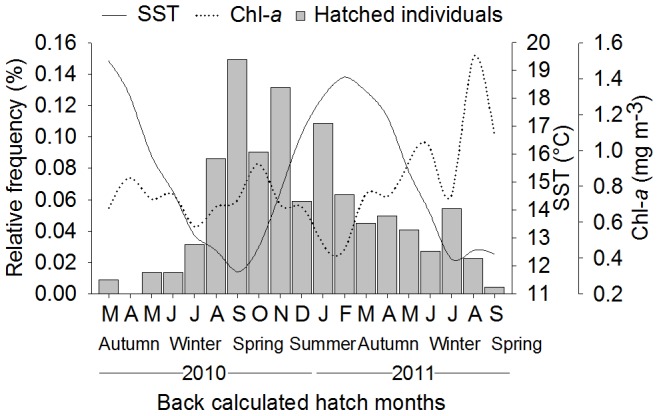
Relative frequency (%) of hatched Octopus tetricus (n = 214) from north-eastern Tasmania, Australia during 2011.Warm months are indicated in bold and cool months are indicated in italic.